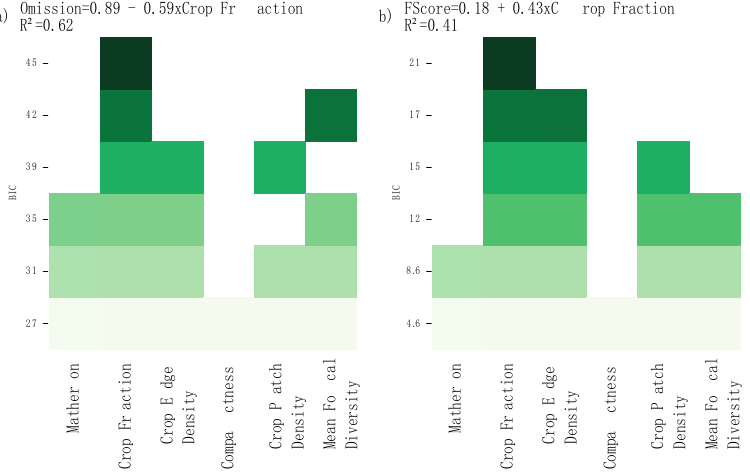
Figure 8. Map of user accuracy estimates for the MODIS LCP cropland classes. The user accuracy is defined as (1-omission errors) and is estimated from the crop